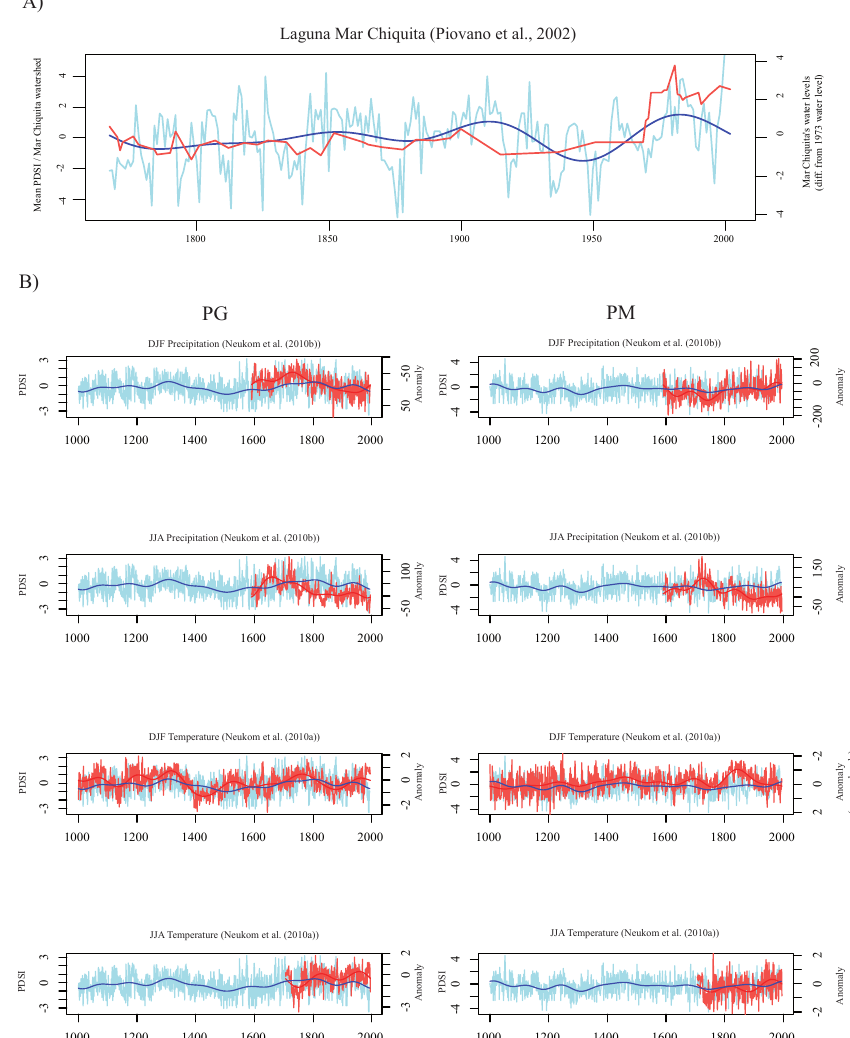
Fig. 7. Comparison with (A) Mar Chiquita (Piovano et al., 2002) and (B) Neukom et al. (2010a, b) temperature and precipitation reconstruc- tions. The summer PDSI reconstruction is always in blue, and the other works are in red. We present only the comparison for PG and PM to emphasize the contrasts. Bold (red and blue) lines represent 50 yr smoothings.